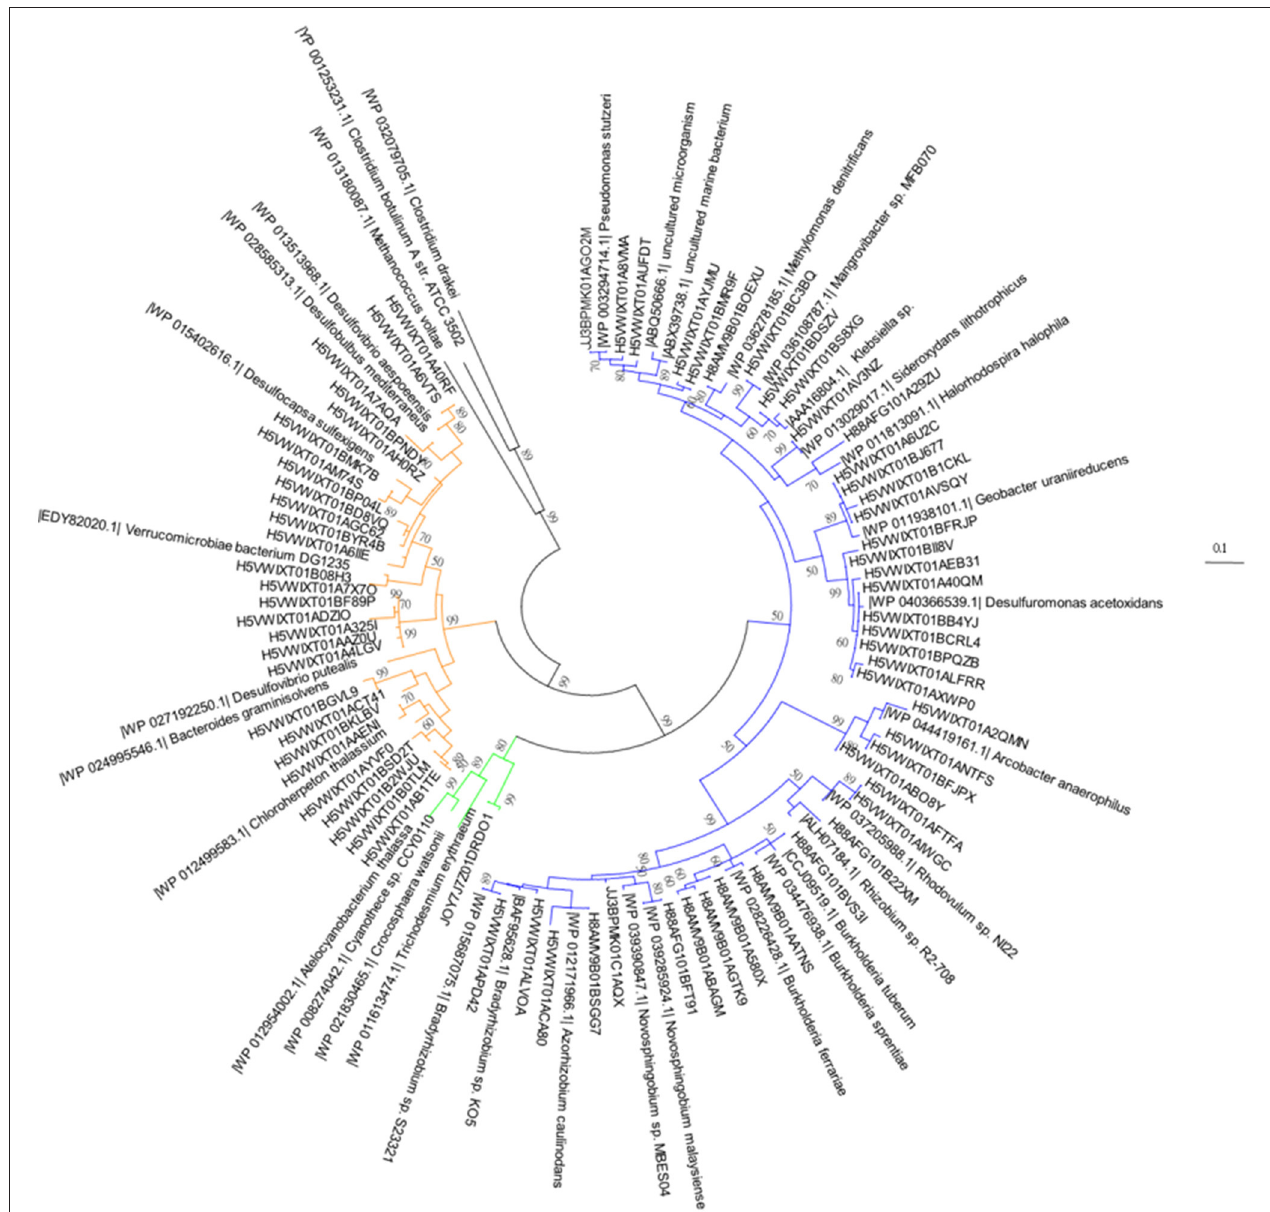
FIGURE 2 | A neighbor-joining phylogentic tree constructed with nifH gene amino acid sequences. Samples were taken 2 days prior to the addition of the SD or A addition. The differently-colored sequences are representative sequences of the OTUs revealed in this study. The sequences fall into Cluster I proteobacteria (blue), Cluster III (yellow), and cyanobacteria (green). The accession numbers of each reference sequence are shown in front of the sequence names.